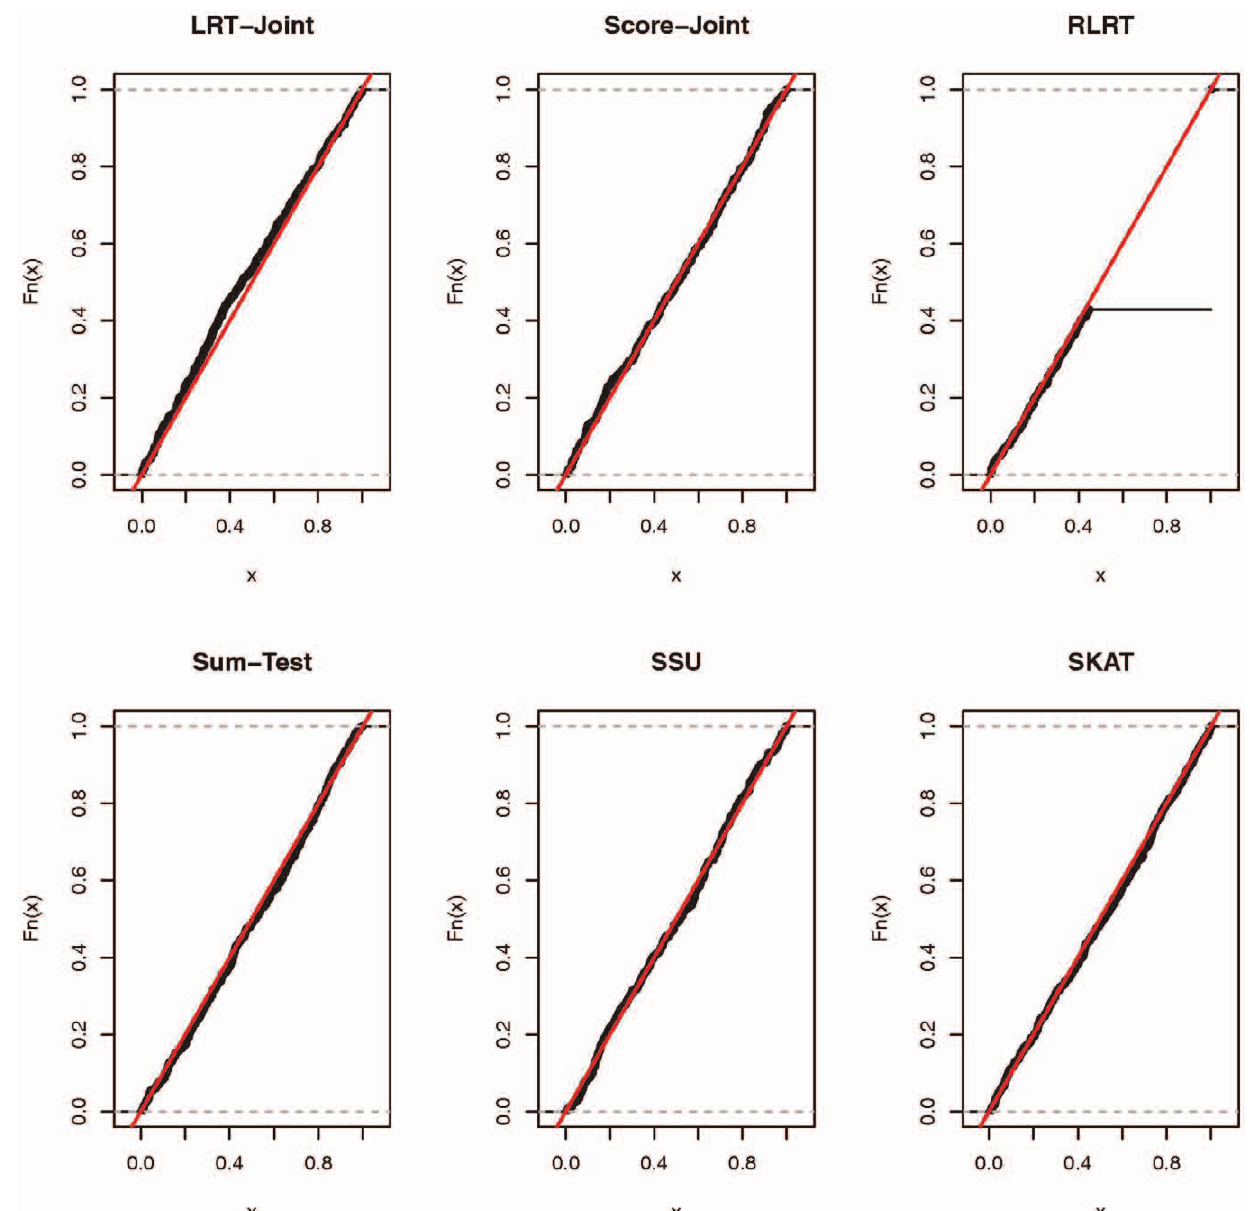
Figure 1. Empirical cumulative distribution function ( ECDF ) of the p -values under the null for continuous trait.